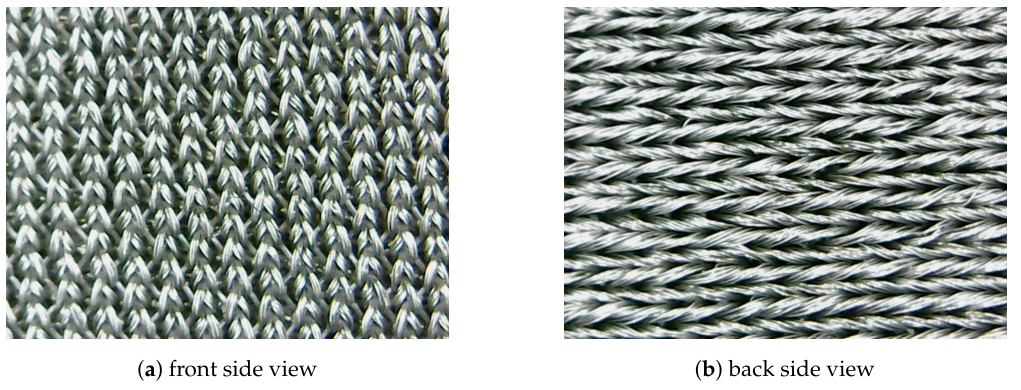
Figure A3. The microscopic view of the fabric after the